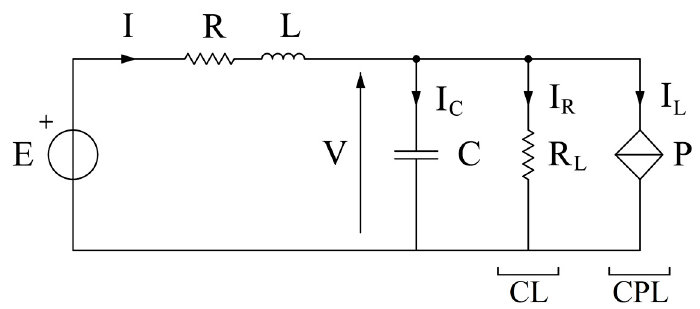
Figure 2. DC microgrid equivalent circuit model.